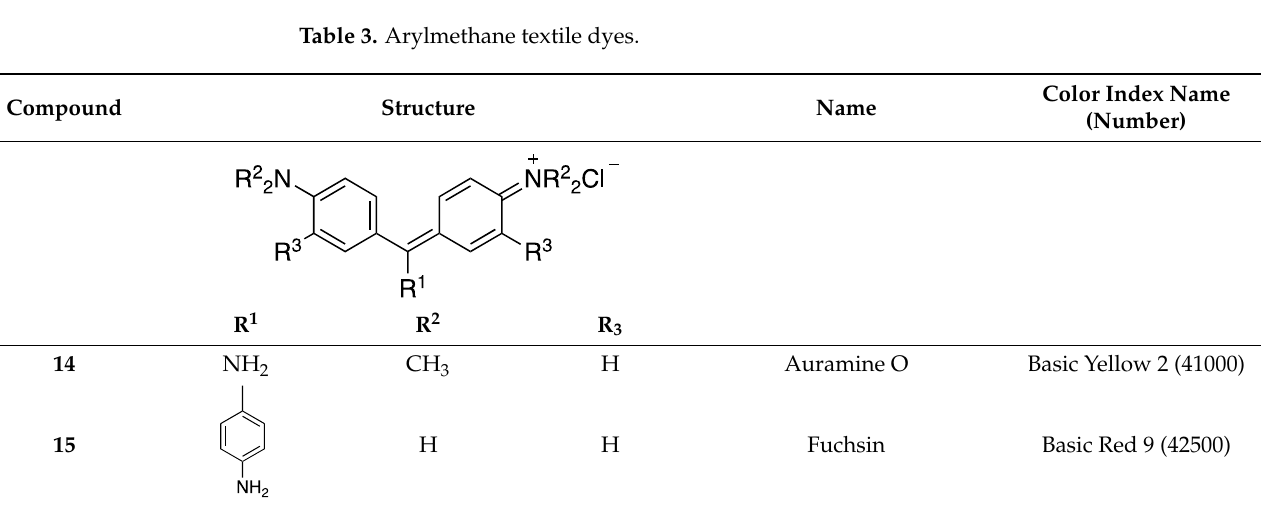
Table 3. Arylmethane textile